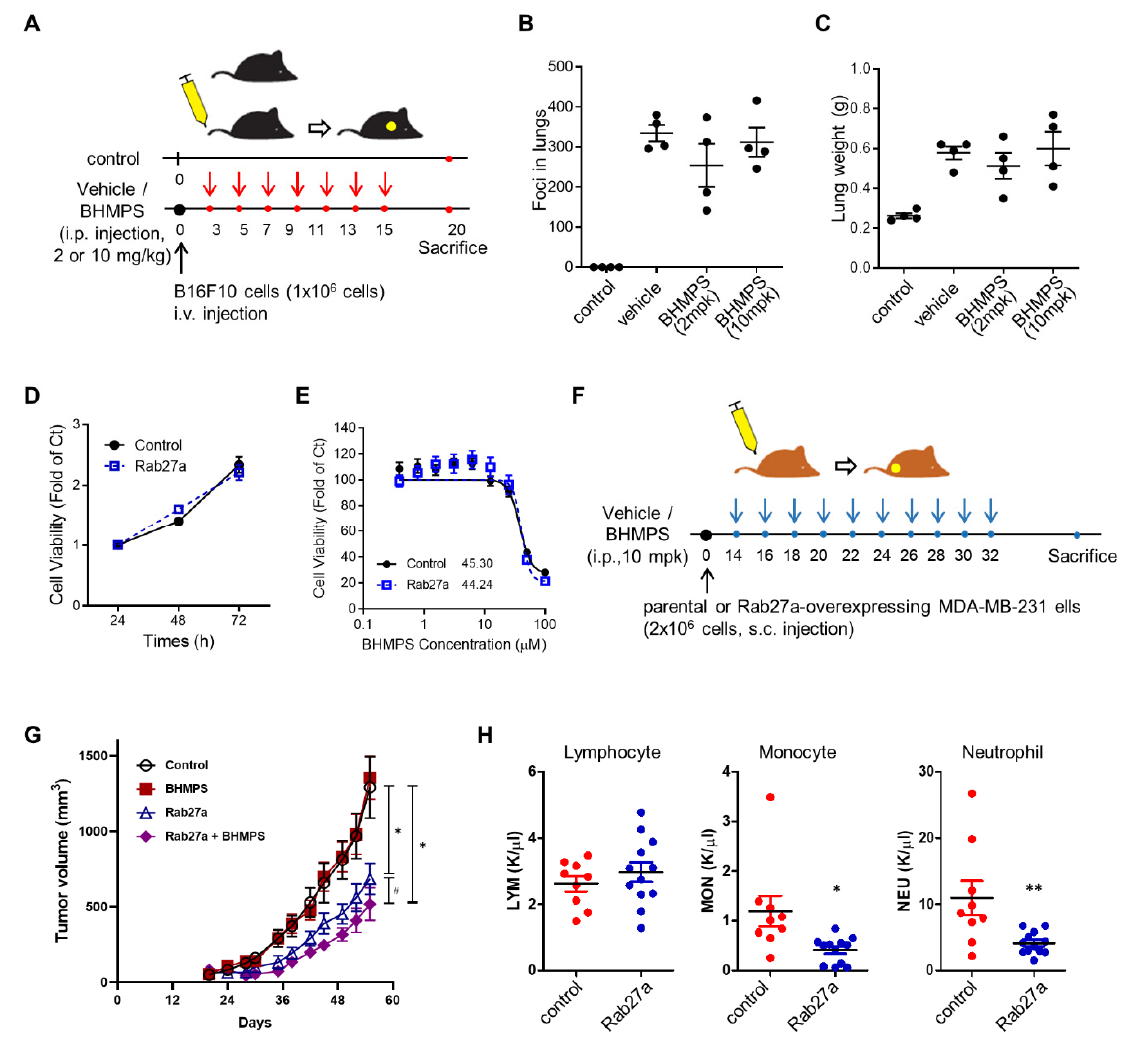
Figure 6. BHMPS suppresses the growth of Rab27a-overexpressed tumor. ( A ) Schematic diagram of in vivo BHMPS treatment in the experimental lung metastasis model. ( B ) B16F10 cells (1 × 10 6 cells/mouse) were injected intravenously into the tail vein of C57BL/6 mice ( n = 4 mice/group). Three days after tumor cell injection, BHMPS (2 or 10 mg/kg) or vehicle was administrated intraperitone- ally every 2 d for a total of six times. After mouse sacrifice, numbers of cell colonies metastasized to the lungs were counted and the mean ± SE are shown. ( C ) Data shown are the means ± SE of weight of the lungs. ( D ) MTT assay was performed to determine the viability of Rab27a-overexpressing cells. The viability from 24 h to 72 h after seeding with the same number of cells was analyzed. Data shown are the means ± SD of three independent experiments. ( E ) MTT assay was performed to de- termine the effect of BHMPS on the viability of Rab27a-overexpressing cells. Cells were treated with the indicated concentrations of BHMPS (0–100 µM) for 24 h. Data shown are the means ± SD of three independent experiments. ( F ) Schematic of in vivo BHMPS administration in the tumor xenograft model. ( G ) Control (parental MDA-MB-231 cells) or Rab27a-overexpressed MDA-MB-231 cell (2 × 10 6 cells/mouse) were injected subcutaneously into the hind thigh of BALB/c nude mice ( n = 6–8 mice/group). Fourteen days after tumor cell injection, BHMPS (10 mg/kg) or vehicle was